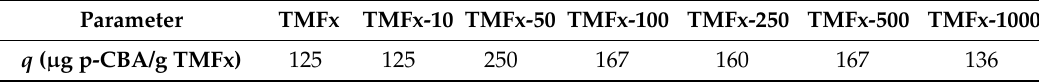
Table 3. Adsorption loading of p-CBA ( C o = 4 µ M) onto the TMFx catalysts ( C TMFx = 0.5 mg/L).